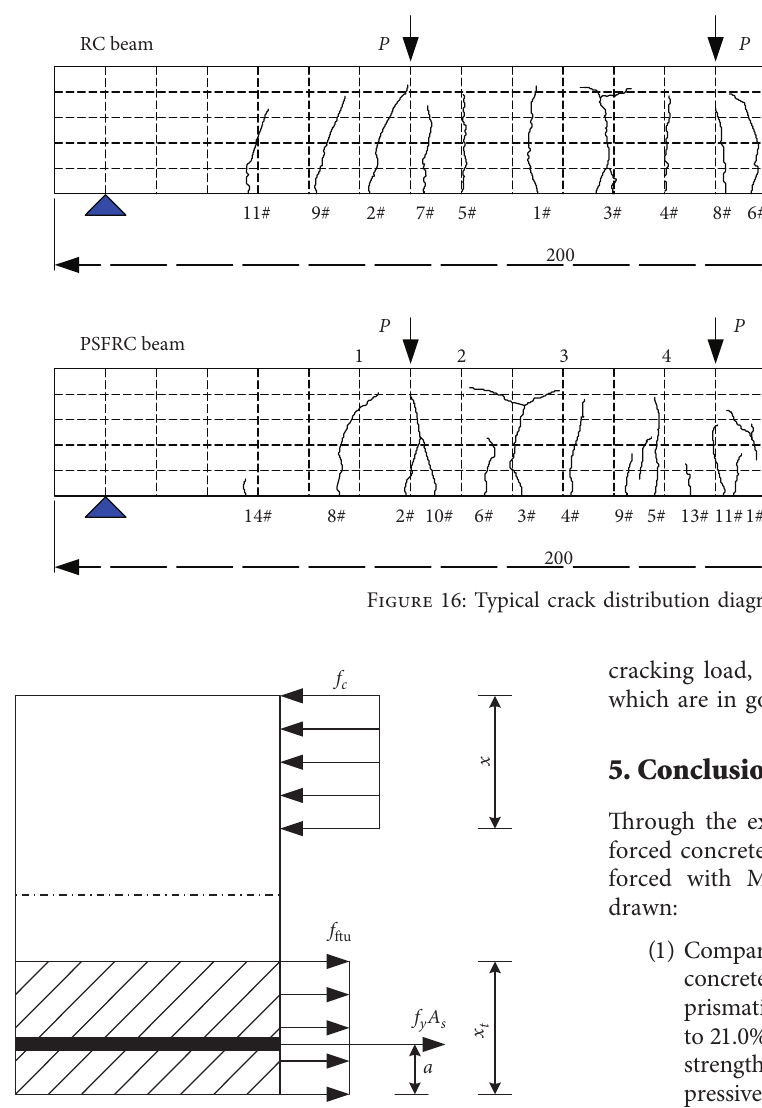
Figure 17: Ultimate moment calculation diagram of normal section. Table 7: Calculated and experimental results of the cracking load and ultimate